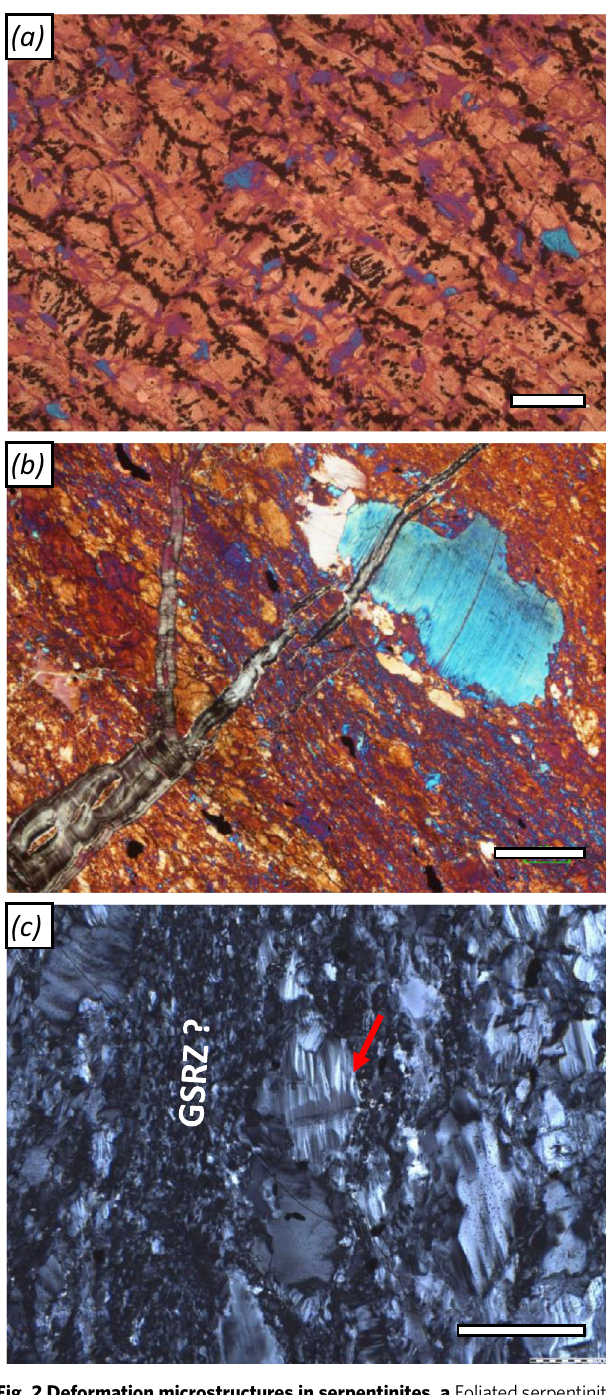
Fig. 2 Deformation microstructures in serpentinites. a Foliated serpentinite with crystallographic preferred orientation (CPO) and aligned Fe-oxides tracing former polygonal, now fl attened mesh cells (crossed polarized image (xpol) with 1 λ -plate; sample OM20-13); b Serpentinite mylonite with strong CPO of lizardite and bastite porphyroclast, cut by a younger serpentine vein with anomalous extinction color (xpol with 1 λ -plate). c Grain size reduction in shear bands (GSRZ), and deformation lamellae and kinking (red arrow in c ) of larger serpentine grains (xpol). ( b and c are both from sample BT1B_74-1_59- 61). Scale bars: 200 µ